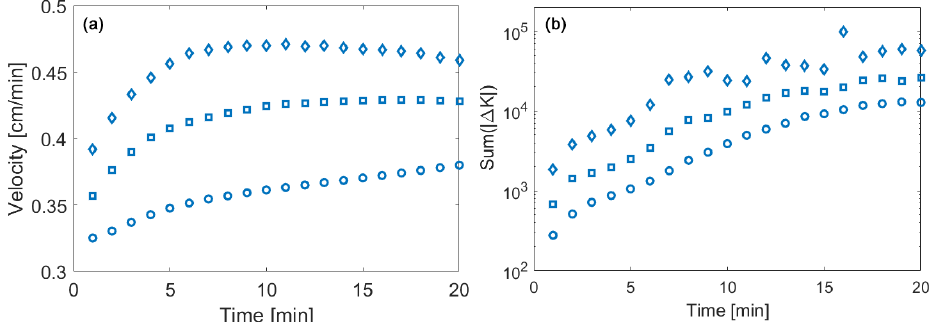
Figure 4. Temporal evolution of (a) the weighted mean velocity n R v (open symbols) and (b) the sum of all conductivity changes over 1min. = 1 (circles), 3 (squares), and 5 Results correspond to σ 2 0